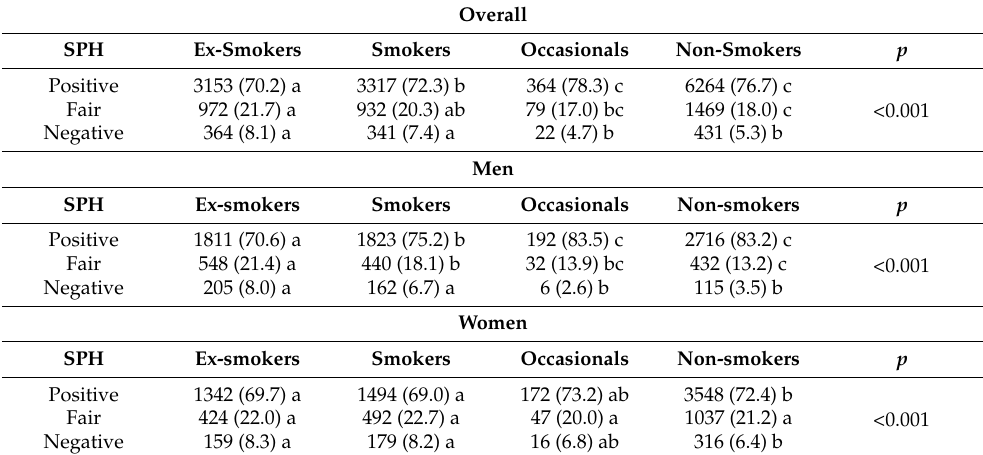
Table 2. Relationship between smoking and self-perceived health in the Spanish population, by gender.